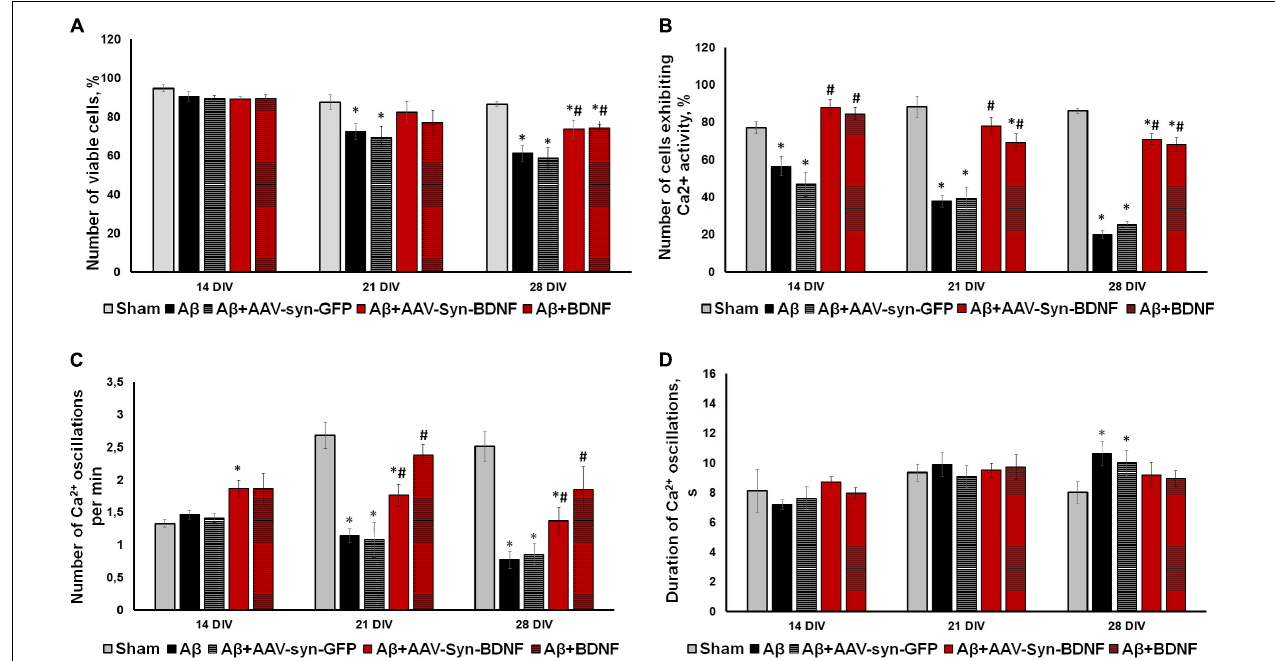
FIGURE 7 | (A) Analysis of cell viability in primary hippocampal cell cultures under exogenous administration of A β and BDNF. * vs. “Sham,” # vs. “A β ,” p < 0.05, ANOVA. On DIV 21 and 28 when A β and AAV-Syn-EGFP application caused a significant decrease in culture viability, both recombinant BDNF and AAV-Syn-BDNF preserved the number of viable cells. (B–D) Main parameters of spontaneous calcium activity in primary hippocampal cell cultures under chronic exogenous application of A β and BDNF during development in vitro . (B) Proportion of cells exhibiting Ca 2 + activity; (C) number of Ca 2 + oscillations per min; (D) duration of Ca 2 + oscillations. ∗ vs. “Sham,” # vs. “A β ,” p < 0.05, ANOVA. On DIV 28, the activity of cells in BDNF-treated cultures was significantly higher compared to those in cultures exposed to chronic A β . The frequency of Ca 2 + oscillations in the A β +BDNF and A β +AAV-Syn-BDNF groups was significantly higher than that in the A β group. Moreover, the duration of Ca 2 + oscillations in the BDNF-treated group did not differ from that in the sham group on DIV 28. The parameters of spontaneous calcium activity in the “A β +AAV-Syn-EGFP” group did not differ from the values in the “A β ” group.